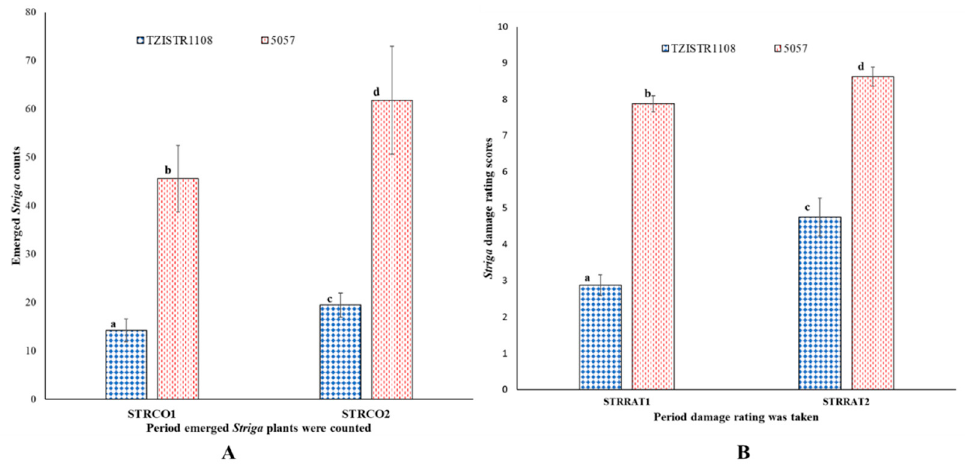
Figure 11. Field estimates of Striga resistance related traits. ( A ) Mean values for number of emerged Striga hermonthica plants on both lines at 10 weeks after planting (STRCO1) and 12 weeks after planting (STRCO2). ( B ) Mean Striga damage ratings of both lines at 10 weeks after planting (STRRAT1) and 12 weeks after planting (STRRAT2). The different letters (a, b, c and d) show significant differences among the groups ( α = 0.05). The bars show standard error.